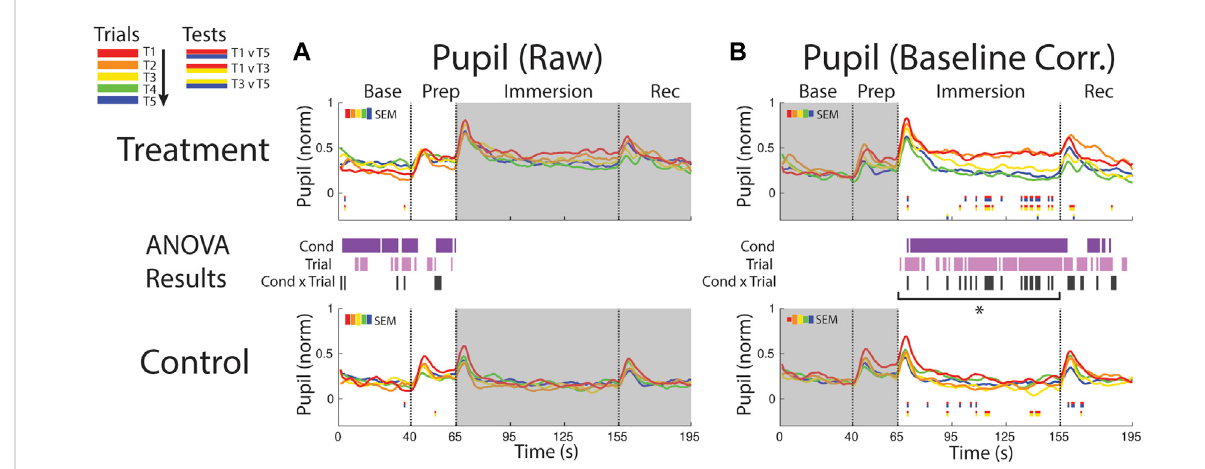
FIGURE 8 Effects of treatment and repeated trial exposure on pupil size. Pre-exposure and evoked stress effects are re fl ected in (A) raw and (B) baseline corrected/normalized plots, respectively. Each panel contains a separate plot for the treatment and control condition, with the mean response across participants in each repetition trial (T1-T5) represented in each plot by a different color (ROYGB). Horizontal lines positioned between treatmentandcontrolplotsindicatestatisticallysigni fi cantANOVAmaineffectsofcondition(darkpurple),trial(lightpurple)andtheconditionx trial interaction (dark gray) at designated timepoints ( p null < 0.05). Horizontal red/blue, red/yellow and yellow/blue lines at the base of treatment and control plots respectively indicate statistically signi fi cant pairwise comparison results for T1 v T5, T1 v T3 and T3 v T5 at the designated